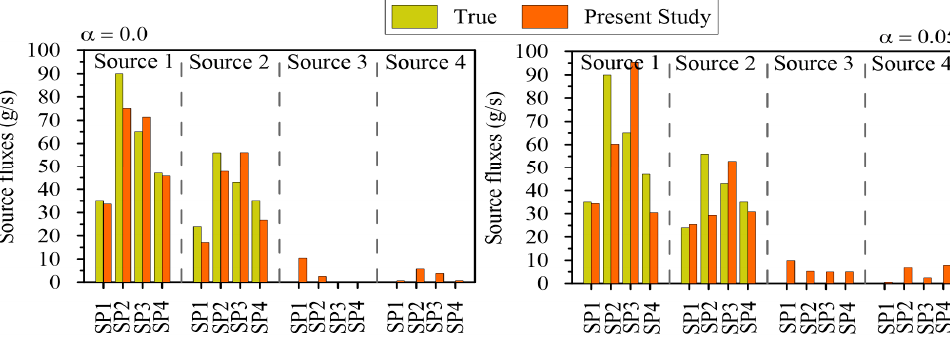
Figure 11. Recovered release histories of sources 1, 2, 3 and 4 in error-free data condition ( α = 0) and in error-perturbed data condition ( α = 0.05).